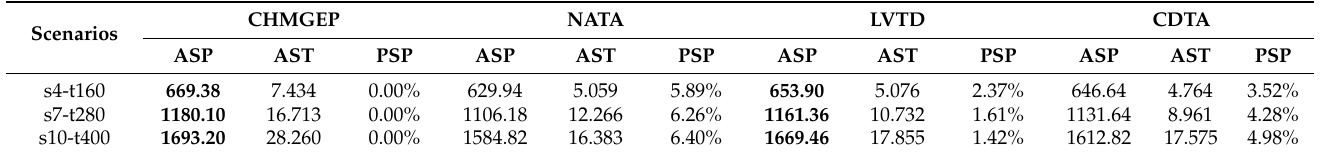
Table 8. The comparative results of CHMGEP with heuristic algorithms.